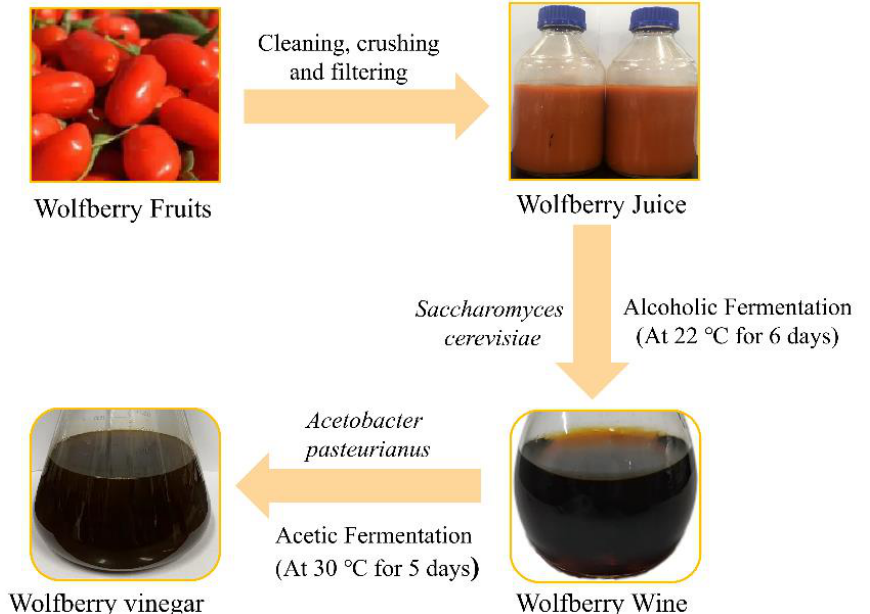
Figure 3. Vinegar production processes of wolfberry fruit.